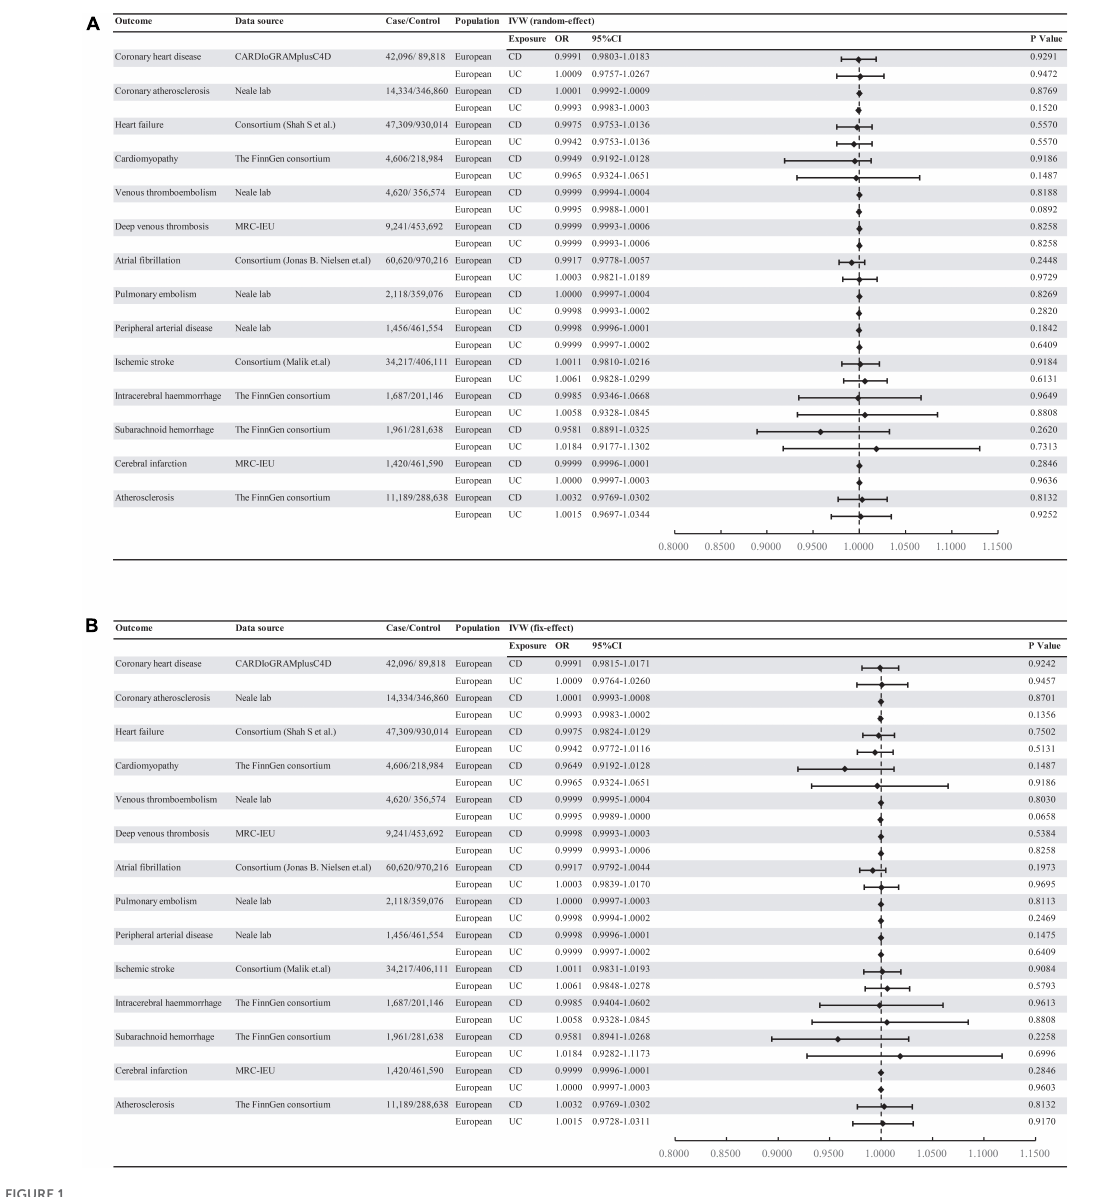
website. The data are free to download and can be used without